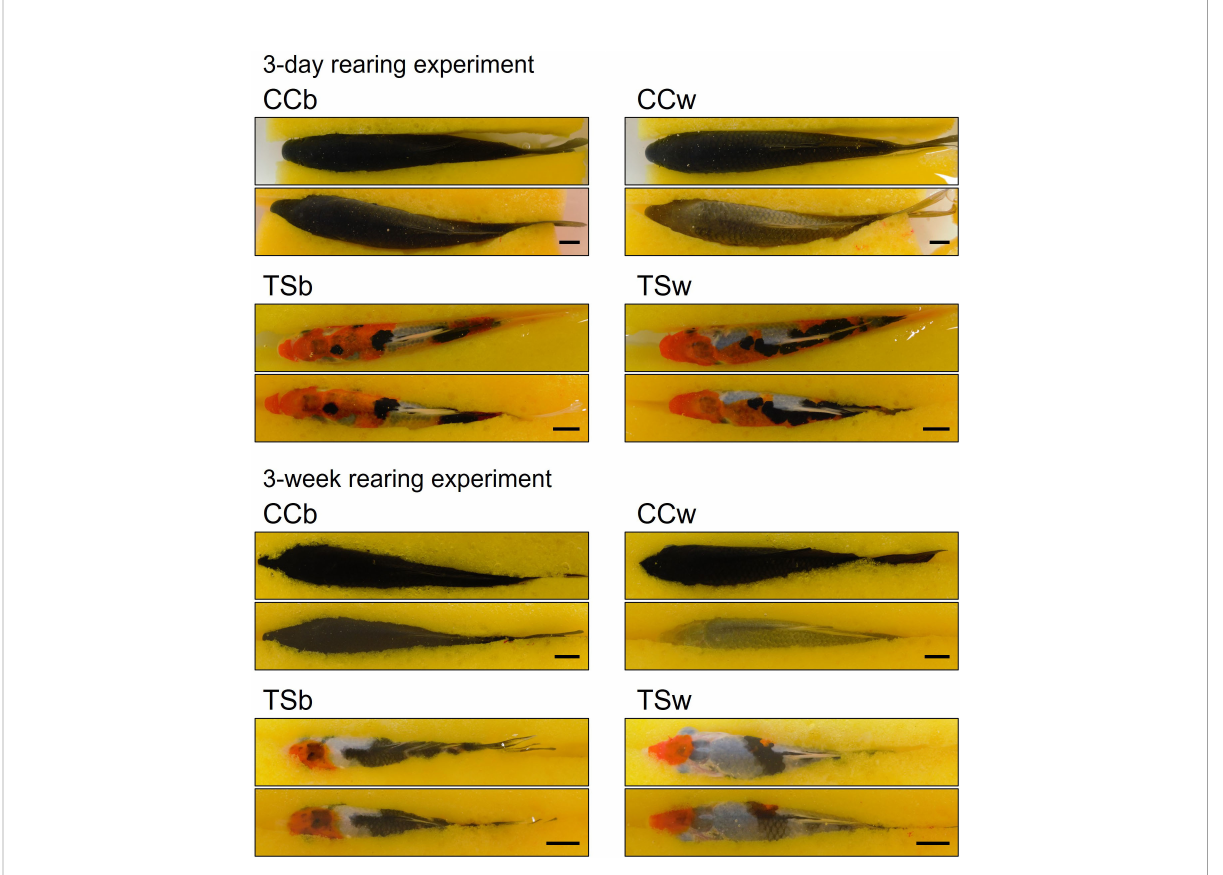
FIGURE 1 Effects of background color on skin color. Initial (upper) and fi nal (lower) images of the dorsal skin of representative fi sh in 3 day- or 3 week- experiment. CCb, black-acclimated common carp; CCw, white-acclimated common carp; TSb, black-acclimated Taisho-Sanshoku ; TSw, white- acclimated Taisho-Sanshoku . Scale bar = 1